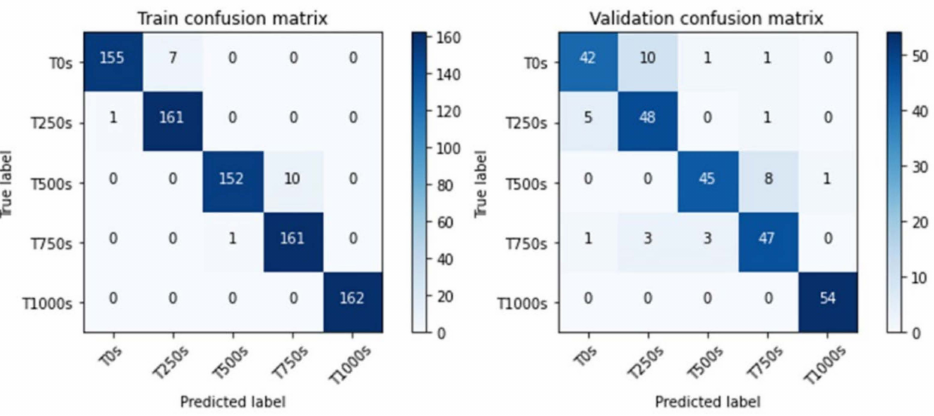
Figure 20. The confusion matrices of the model of the third task. Table 8. Accuracy of the models of the third task using datasets of images illuminated by three different light